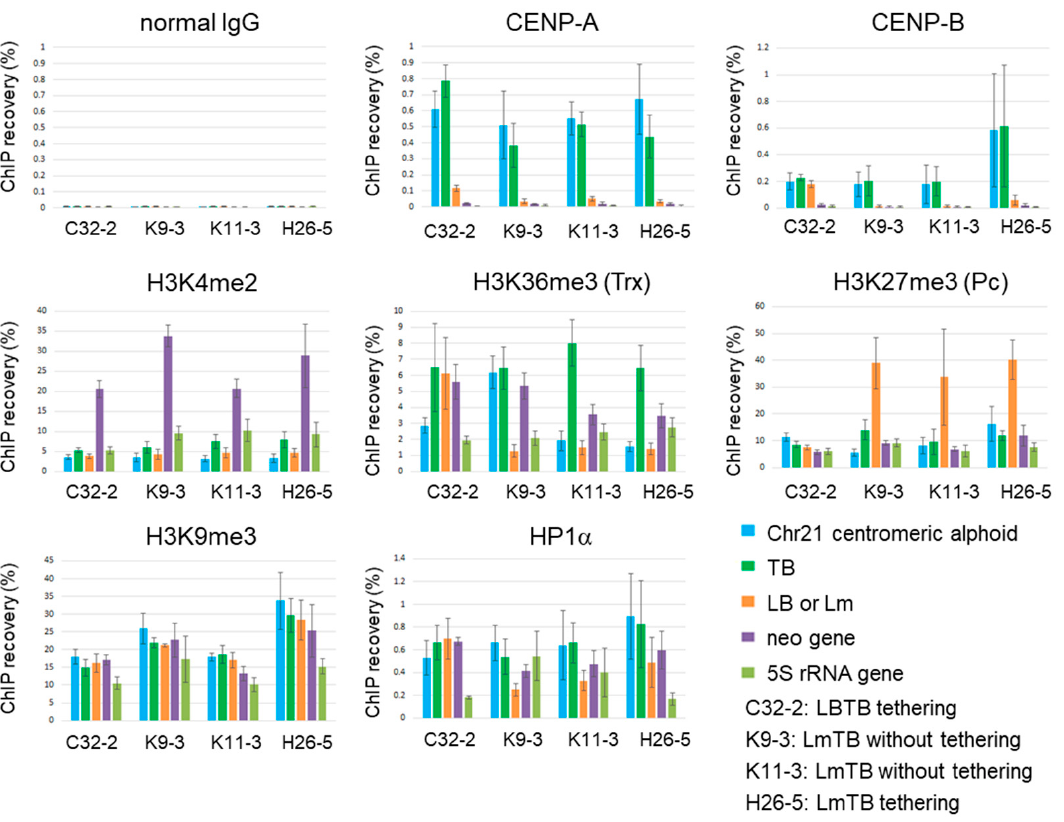
Figure 5. ChIP analysis of the HAC chromatin structure using synthetic alphoid arrays. Results of qPCR. Recovery of TB and LB was calculated from the lacO/tetO ratio obtained by the competitive PCR (Figure S4) as in Figure 3. Error bars indicate standard deviation ( n =